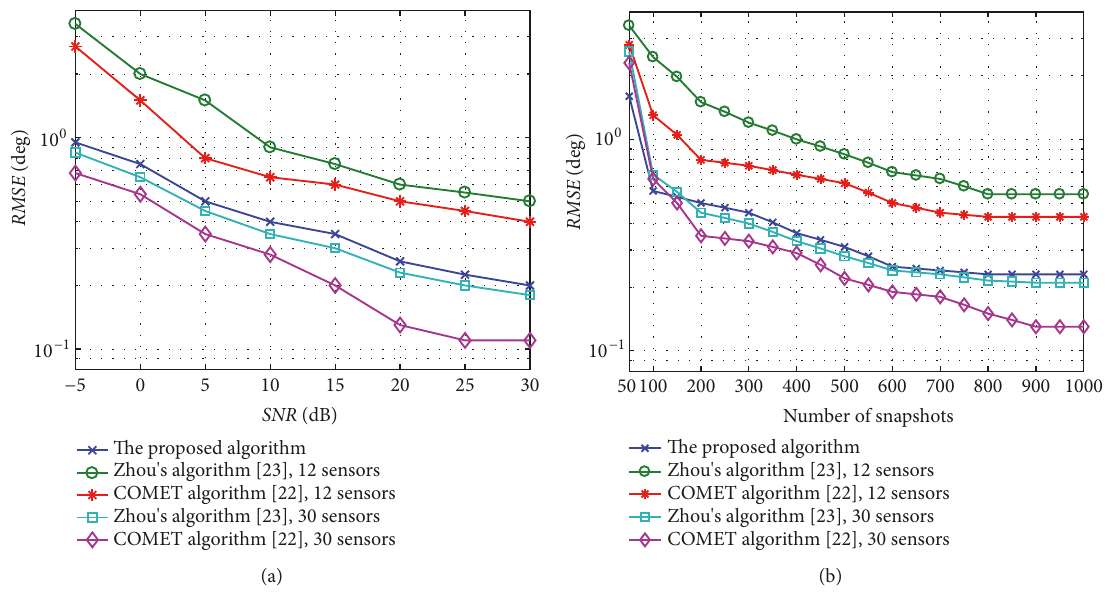
Figure 5: (a) RMSE estimated by three algorithms for 2D ID sources versus SNR ; (b) RMSE estimated by three algorithms for 2D ID sources versus number of